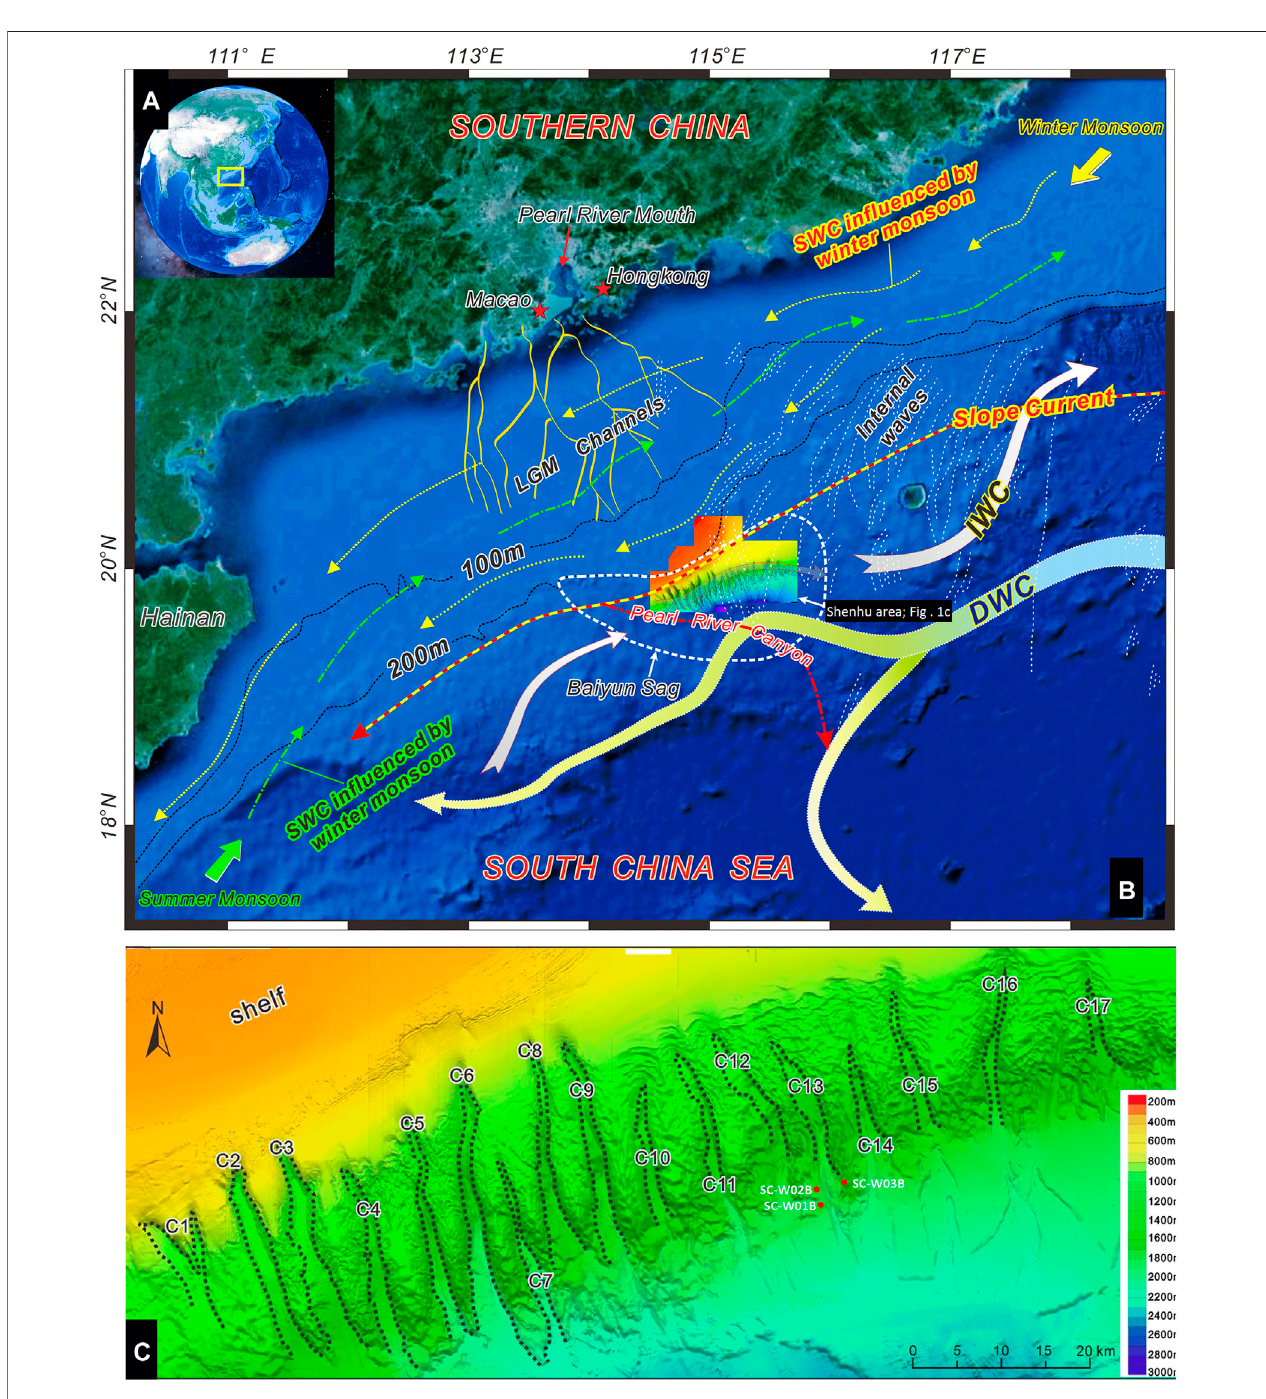
FIGURE1|(A) Location ofthe South China Sea (SCS, from Google Earth). (B) Locationand regionaloceanic circulation model ofthe Shenhu area,SCS, modi fi ed fromWangetal.(2020b).Whitearrows:intermediatewatercurrent;coloredarrows:deep-watercurrent;whitedashedlines:internalwaves(Hsüetal.,2000;Wangetal., 2012; Alford et al., 2015); yellow – red dashed arrow: slope current (Wang et al., 2010). (C) Locations of coring sites of GMGS4 (Yang et al., 2017b; Zhang et al., 2019).